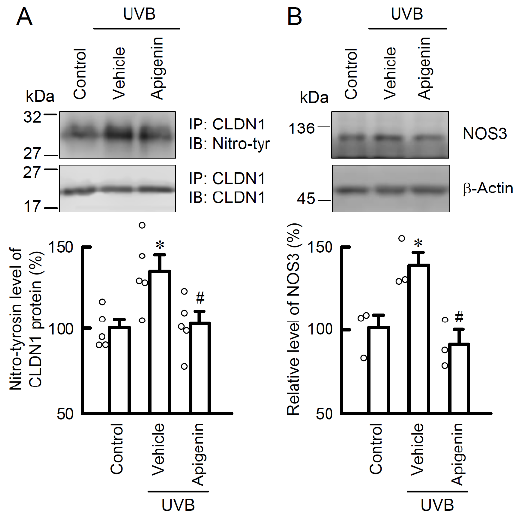
Figure 7. Effect of apigenin on nitration of CLDN1 in the weak UVB-exposed cells. The cells were incubated in the absence (vehicle) and presence of 10 μM apigenin for 30 min, followed by exposure to 5 mJ/cm 2 UVB for 6 h. ( A ) The cell lysates were immunoprecipitated with anti-CLDN1 antibody. The immunoprecipitants were applied to SDS-PAGE and detected using anti-tyrosine nitration (nitro- tyr) and anti-CLDN1 antibodies. The levels of tyrosine nitration of CLDN1 were represented as a percentage of control. n = 3–5. * p < 0.05 vs. control. # p < 0.05 vs. vehicle. ( B ) The cell lysates were applied to SDS-PAGE and detected using anti-NOS3 and anti- β -actin antibodies. β -Actin was used as a loading control. The levels of NOS3 were represented as a percentage of control. n = 3. * p < 0.05 vs. control. # p < 0.05 vs.